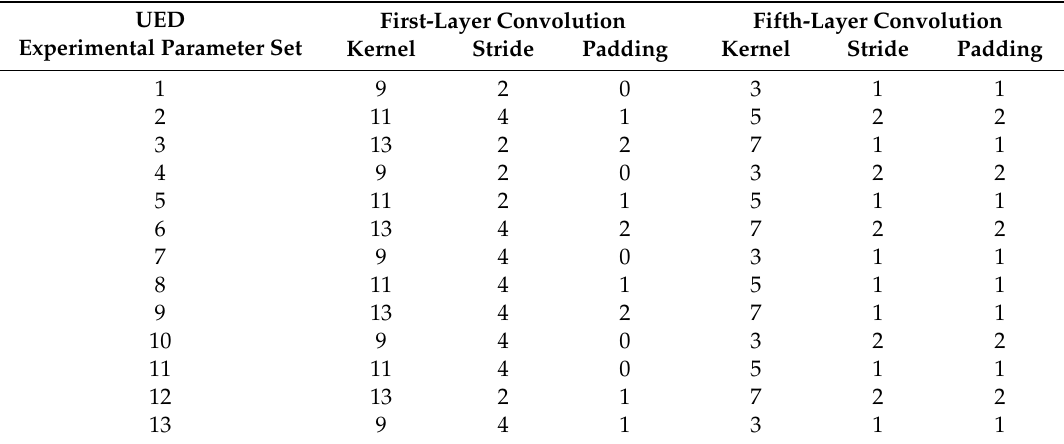
Table 7. The initial parameters used of the uniform experiment table.